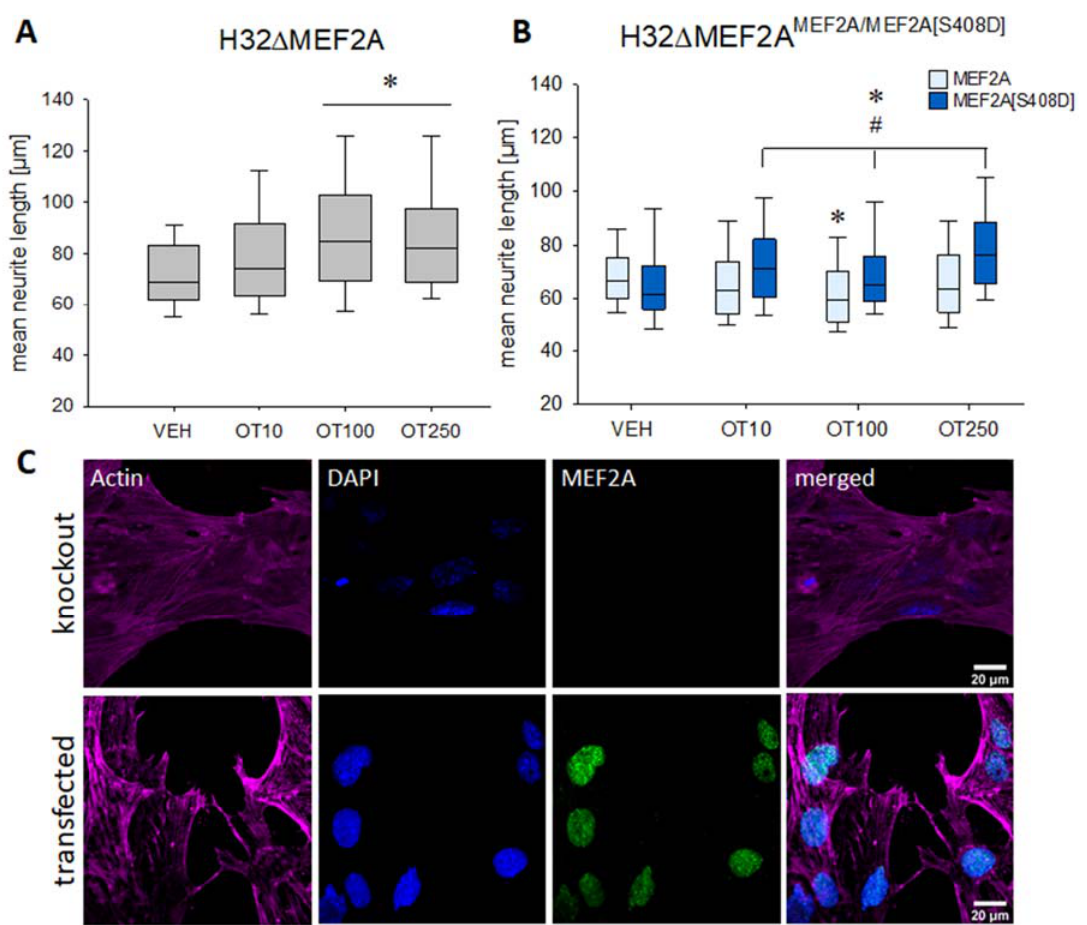
Figure 2. Effects of OT on neuronal morphology in the rat hypothalamic cell line H32. ( A ) Incubation of H32 Δ MEF2A cells with 100 or 250 nM OT leads to a significant neurite elongation. n = 100 cells per treatment; * p < 0.001 vs. VEH. ( B ) H32 Δ MEF2A cells were retransfected with wild ‐ type MEF2A and a mutant version MEF2A[S408D], which mimics a permanently phosphorylated and therefore inactive MEF2A. The wild ‐ type MEF2A generated OT ‐ induced neurite retraction, whilst the mutant MEF2A lacked the ability to induce neurite retraction. Instead, the mutant response to OT resembled the MEF2A knockout cells. n = 100 cells per treatment; two ‐ way ANOVA; * p < 0.031 treatments vs. VEH within the same group; # p < 0.002 groups (wild ‐ type vs. mutant) within the same treatment. ( C ) Representative images of immunofluorescence labelling for MEF2A. Images were sequentially recorded for F ‐ actin (Phalloidin, red, first column), chromatin (DAPI, blue, second column), and MEF2A (green, third column). Merged images are shown for each row in the fourth column. Labels left to the columns indicate the respective cell type (knockout vs. transfected).